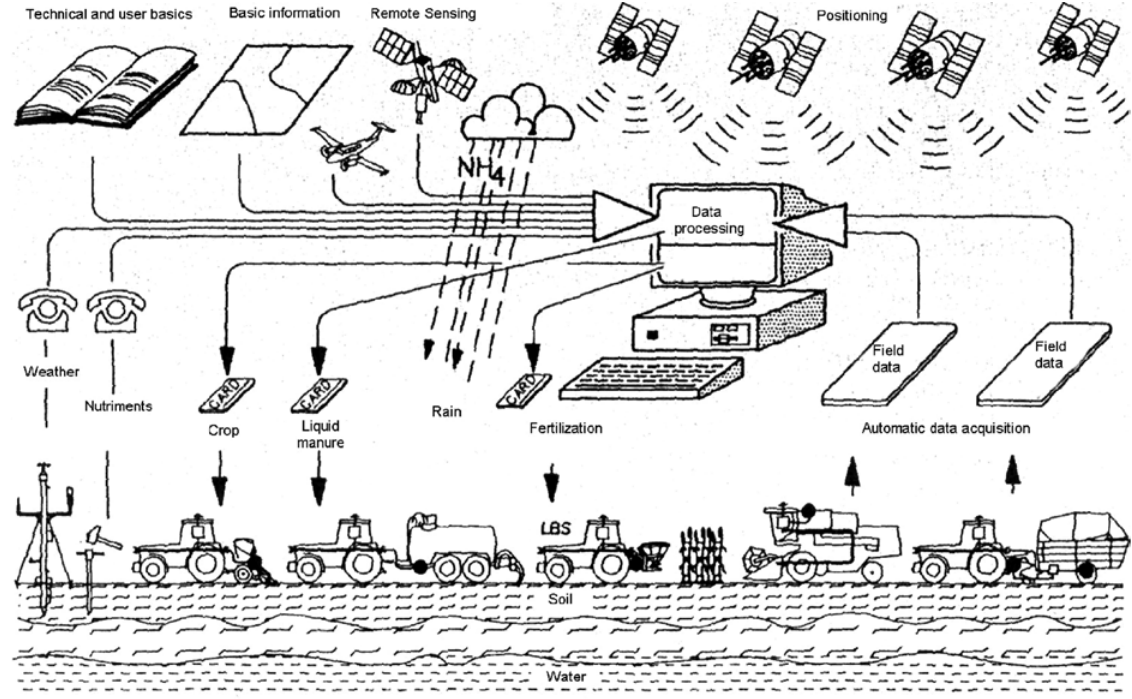
Fig. 5. Overview of the precision farming applications (Auernhammer